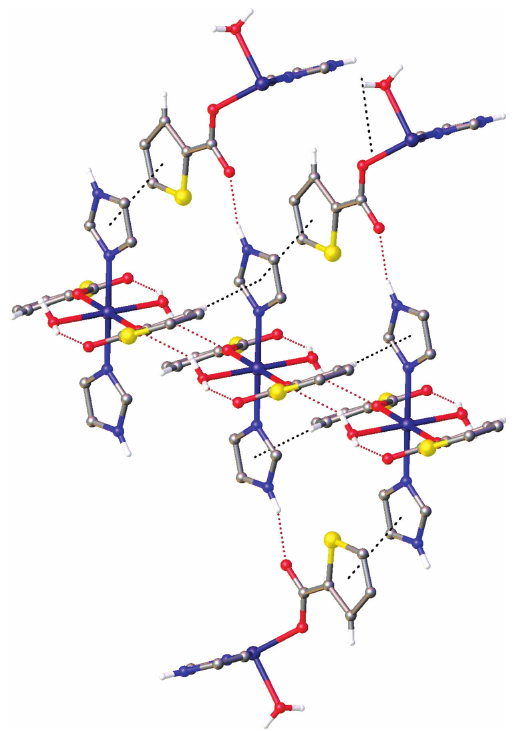
Figure 3 The O-H···O, N-H···O, C-H··· π and π ··· π interactions in Co complex.